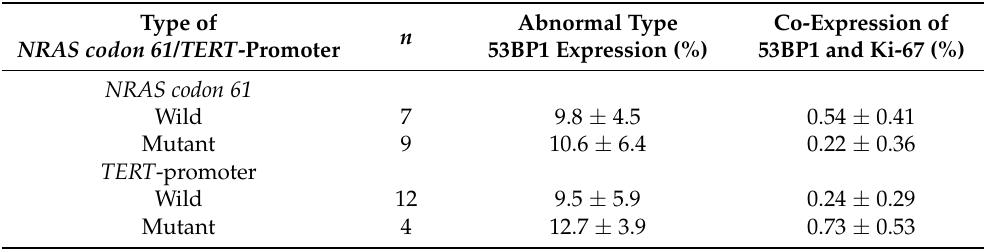
Table 4. Association between type of TP53-binding protein 1 (53BP1) expression and NRAS codon 61 and TERT-promoter mutations in nodule-in-nodule appearance tumor with poorly differentiated component. Type